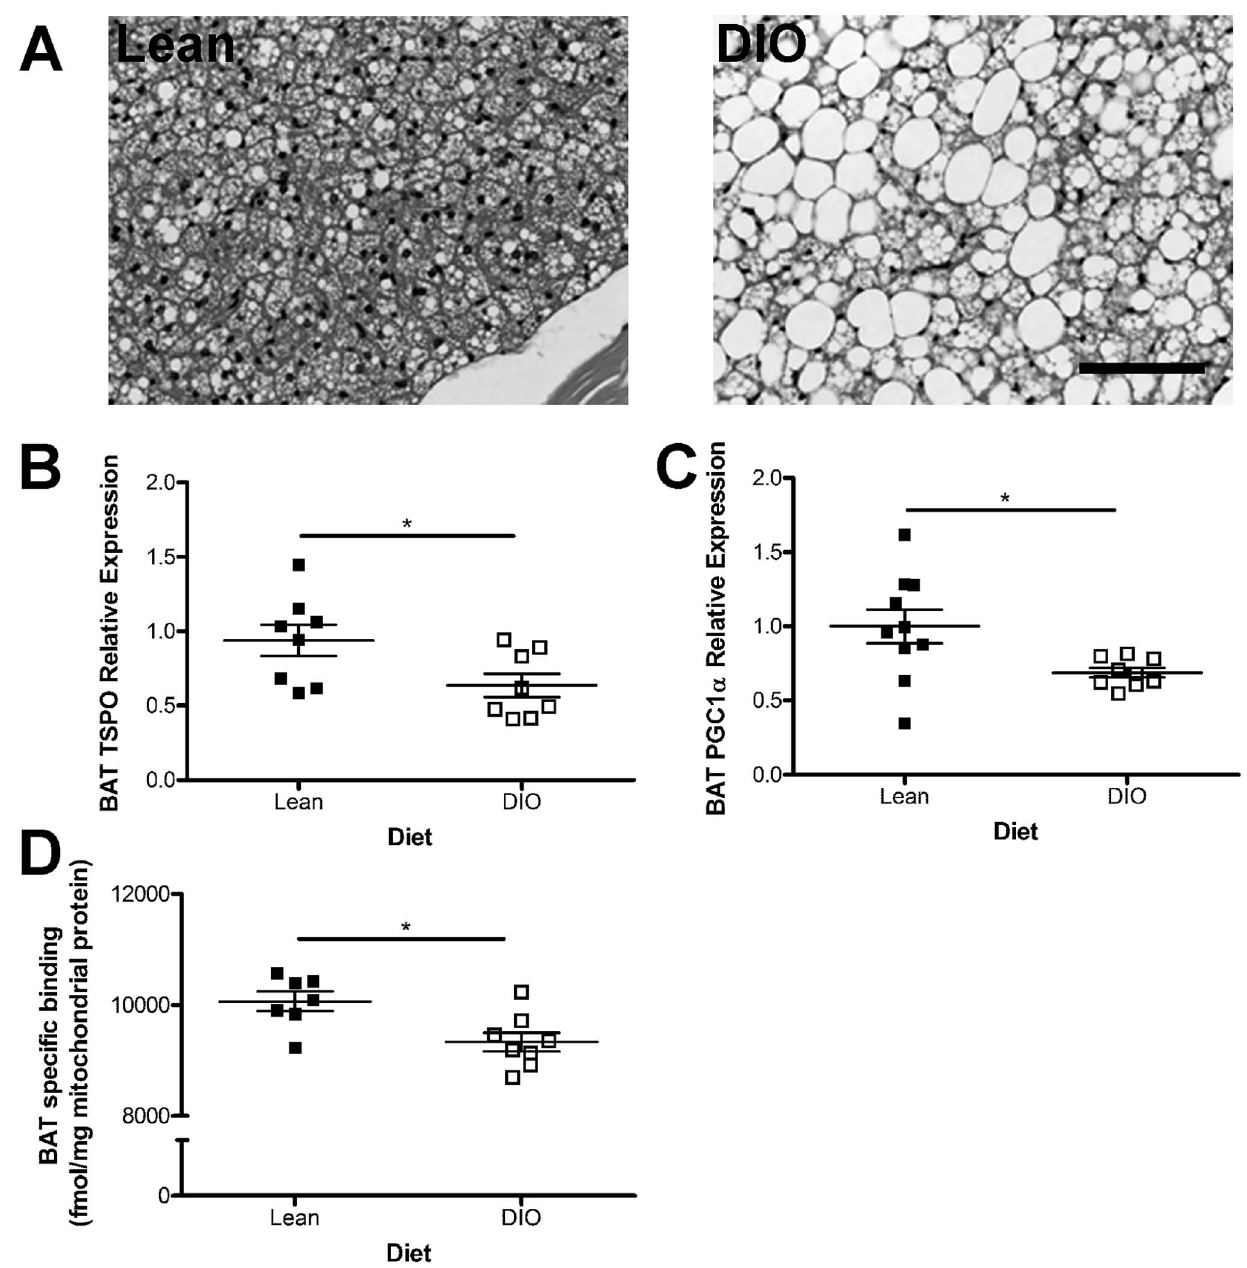
Figure 2. TSPO is down-regulated by diet-induced obesity in brown adipose tissue. A) H&E staining of brown adipose tissue (BAT) from diet-induced obese (DIO) mice revealed increased fat storage and hypertrophic adipocytes as compared to lean controls. B) TSPO mRNA was significantly lower in DIO BAT than controls as was PGC1 a (C). D) Binding of TSPO ligand 3 H-PK11195 in BAT mitochondrial extracts revealed significantly lower expression of TSPO binding sites in DIO mice as compared to controls. Data are expressed as mean 6 standard error. n=7–10. Statistical significance of * p , 0.05 was determined by unpaired t-test. Scale bar=100 m m.